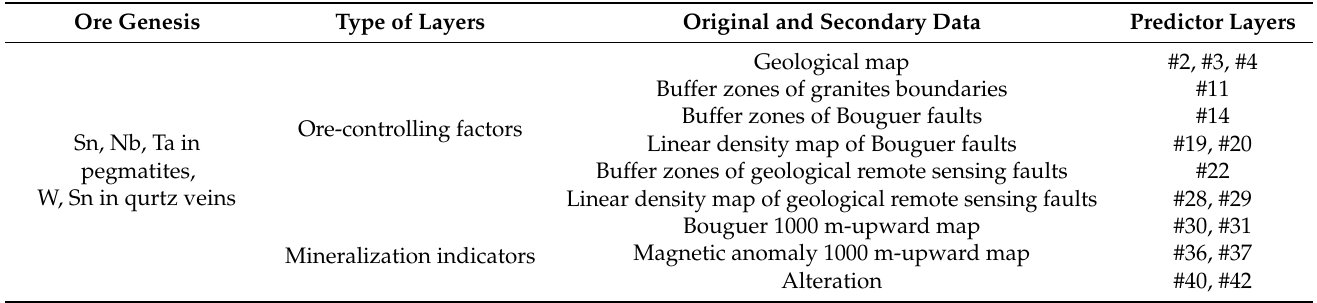
Table 3. Predictive model of W mineralization in